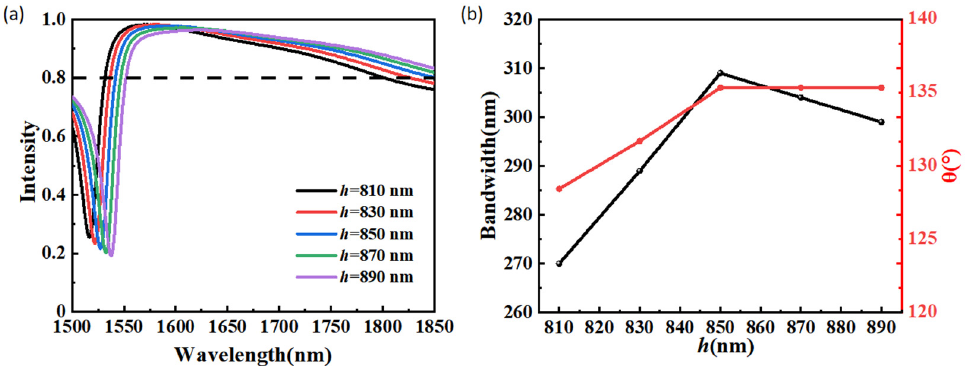
Figure 7. ( a ) The anomalous transmission intensity at different values of h at the wavelength range of 1500–1850 nm. ( b ) Operating bandwidth and the maximum beam split angle in the operating bandwidth as a function of the structure parameter h .